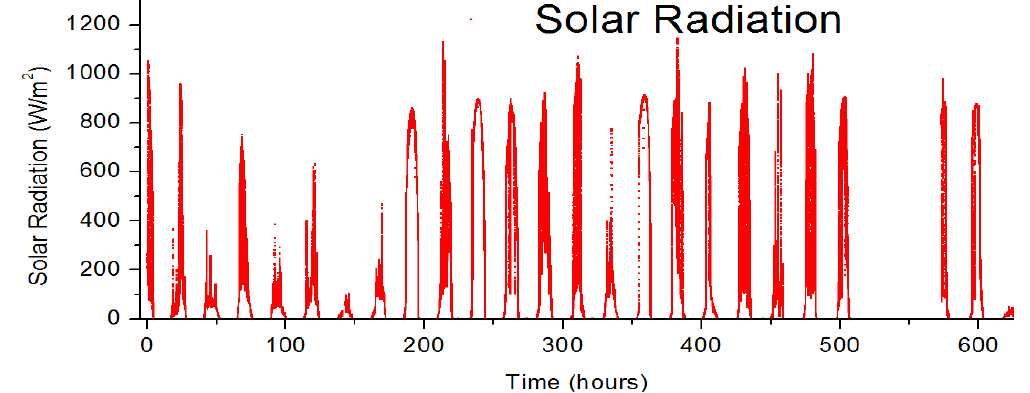
Figure 11. The pyranometer data on the tracking platform for the duration of the outdoor measurements reported in this